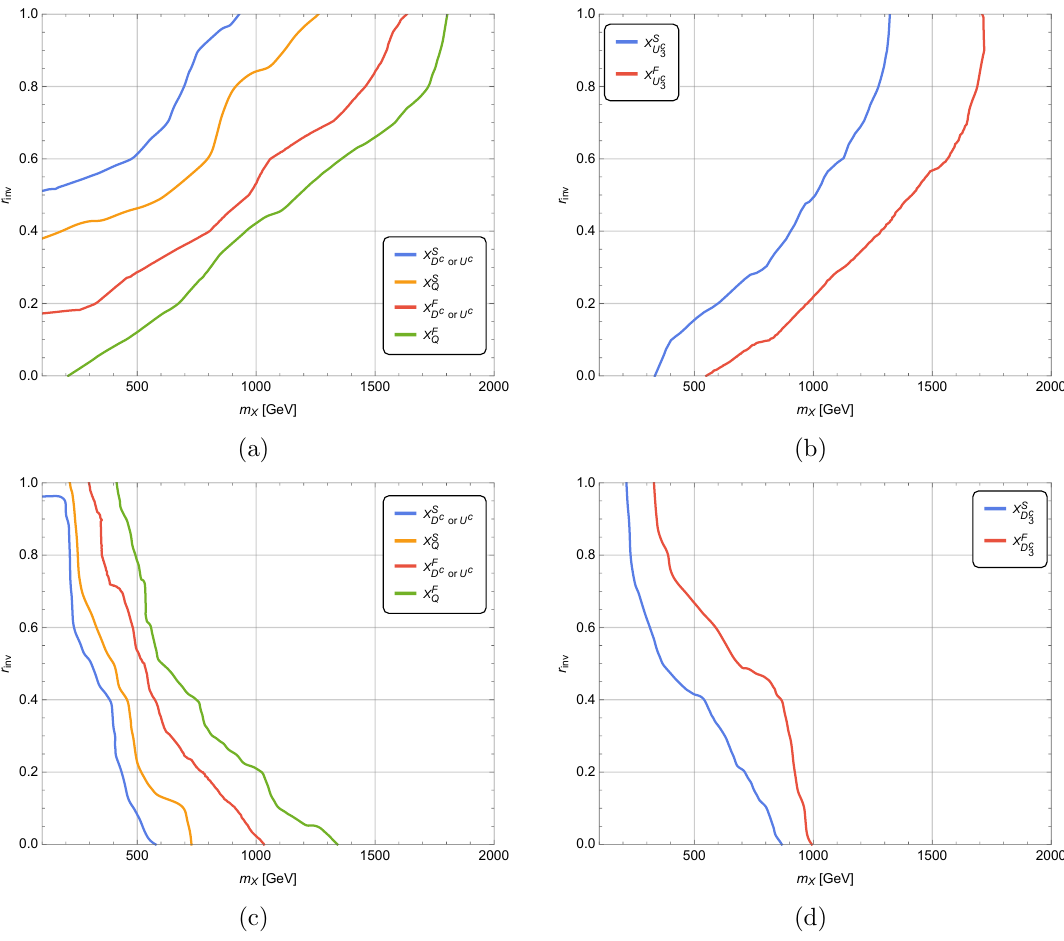
Figure 2. Limits at 95% CLs on mediators of category I that communicate only with (a) (cid:12)rst and second generation quarks, (b) right-handed top quarks for searches targeting large r inv (left- handed top quarks give similar results), (c) (cid:12)rst and second generation quarks and (d) left and right-handed bottom quarks for searches targeting small r inv . Bounds are obtained by recasting the SUSY searches of refs. (a) [37], (b) [42], (c) and (d) [43]. The Hidden Valley group is taken to be SU(3). The excluded regions are left of the